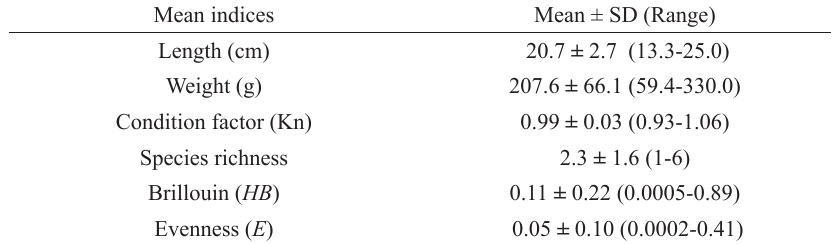
Descriptors of diversity and body parameters for parasites communities of